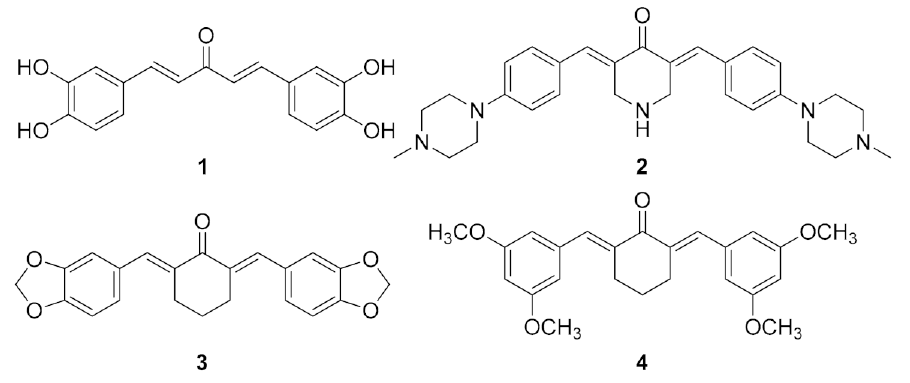
Figure 1. Structures of monocarbonyl analogs of curcumin